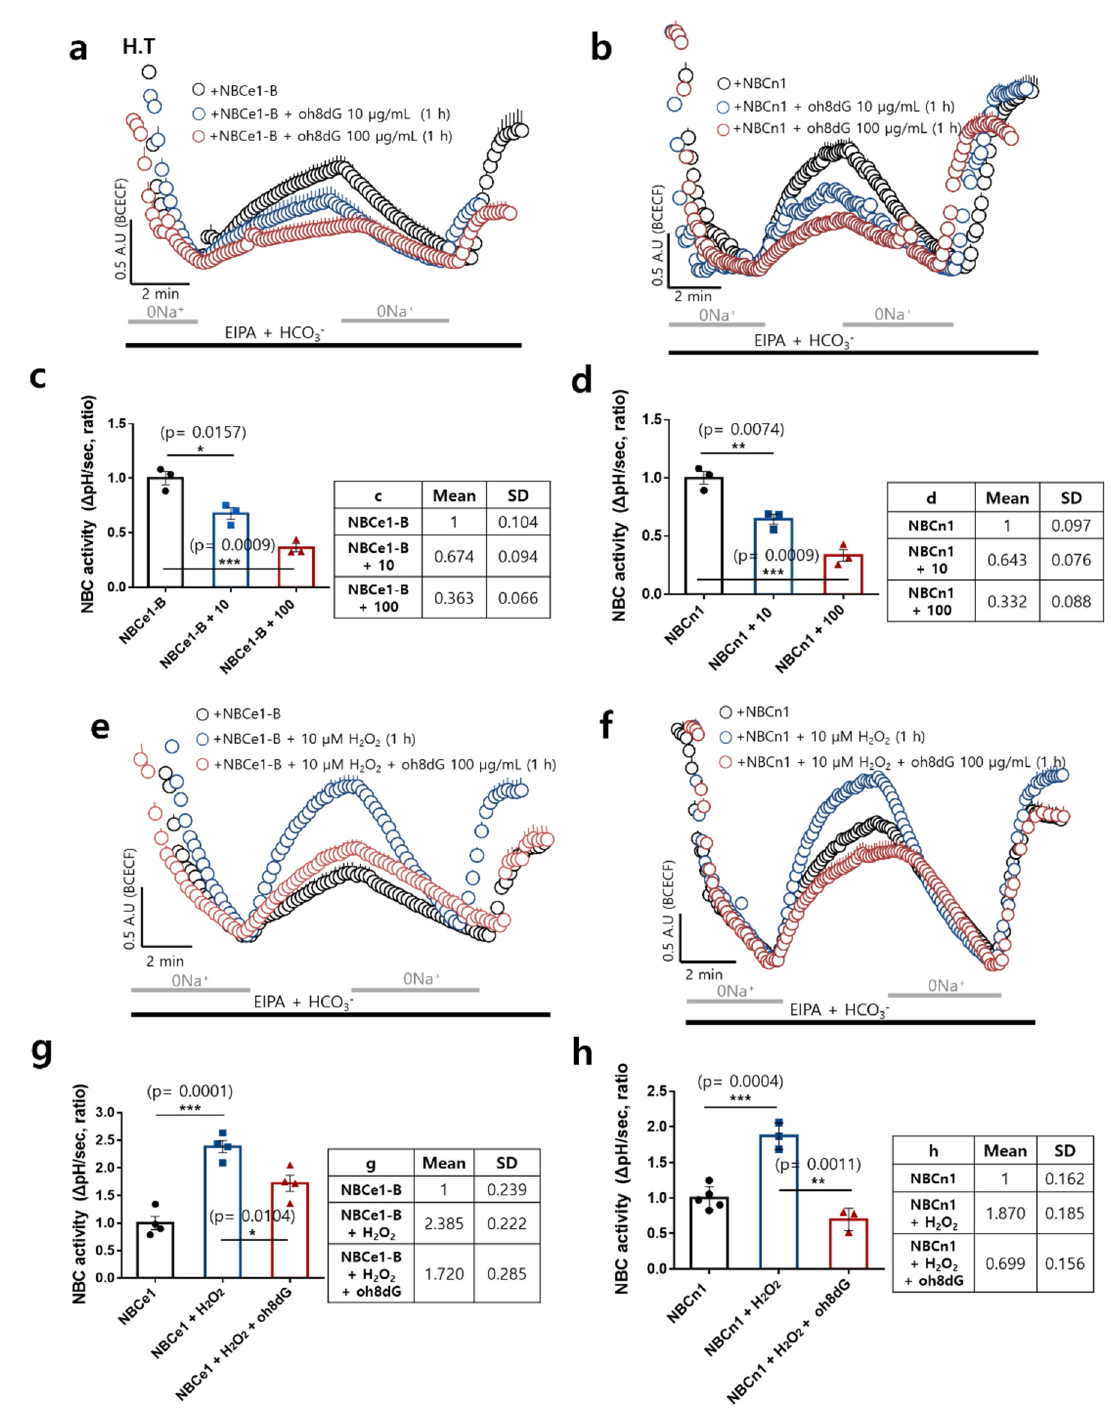
Figure 2. Treatment of oh8dG attenuated ROS-mediated NBC activities. NBC activity was assessed by measuring changes in pH i transfected with NBCe1-B ( a ) and NBCn1 ( b ) plasmids in the presence or absence of oh8dG (10 and 100 µ g/mL) for 1 h in HEK293T (H.T) cells. ( c , d ) The bars represent mean ± SEM ( n = 3, * p < 0.05, ** p < 0.01, and *** p < 0.001). The table represents mean and SD value. NBC activity was assessed by measuring 10 µ M H 2 O 2 –mediated changes in pH i in HEK293T cells, which were transfected with NBCe1-B ( e ) and NBCn1 ( f ) plasmids in the presence or absence of pre- incubation with 10 µ M H 2 O 2 and oh8dG (100 µ g/mL) for 1 h. ( g , h ) The bars present mean ± SEM ( n = 3~5, * p < 0.05, ** p < 0.01, and *** p < 0.001). The table represents mean and SD